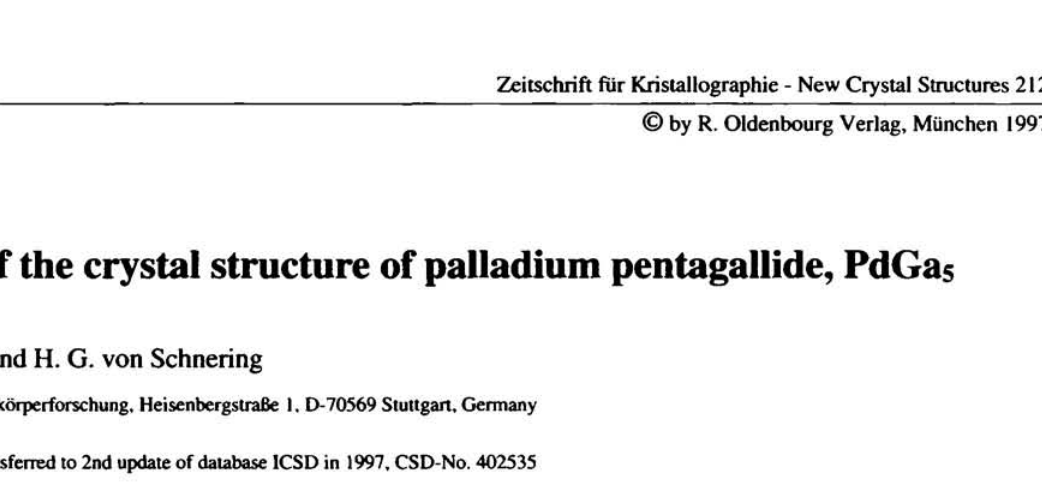
The tetragonal r/24 structure is a three-dimensional system of bicapped tetragonal antiprisms [PdGaio /2] (see Fig.) condensed via common corners to columns along [001] and via common edges to layers parallel (001). Eight Ga(l) atoms form the tetra- gonal antiprismatic fragment of the coordination polyhedron aro- und the Pd atom. Two Ga(2) atoms cap this fragment along [001 ], forming linear -Ga-Pd-Ga- chains. The important interatomic